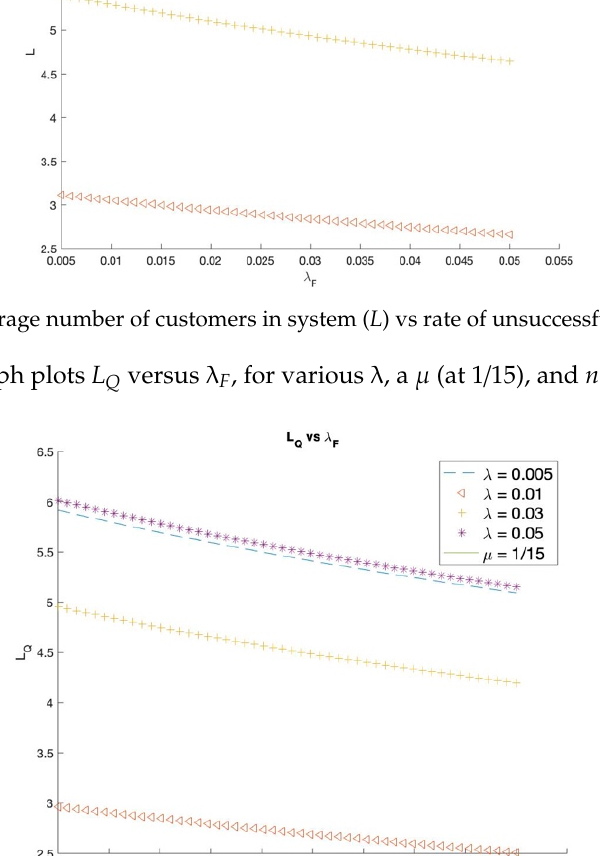
Figure 12. Average number of customers in queue ( (cid:1838) (cid:3018) ) vs rate of unsuccessful arrival ( λ (cid:3007) ).